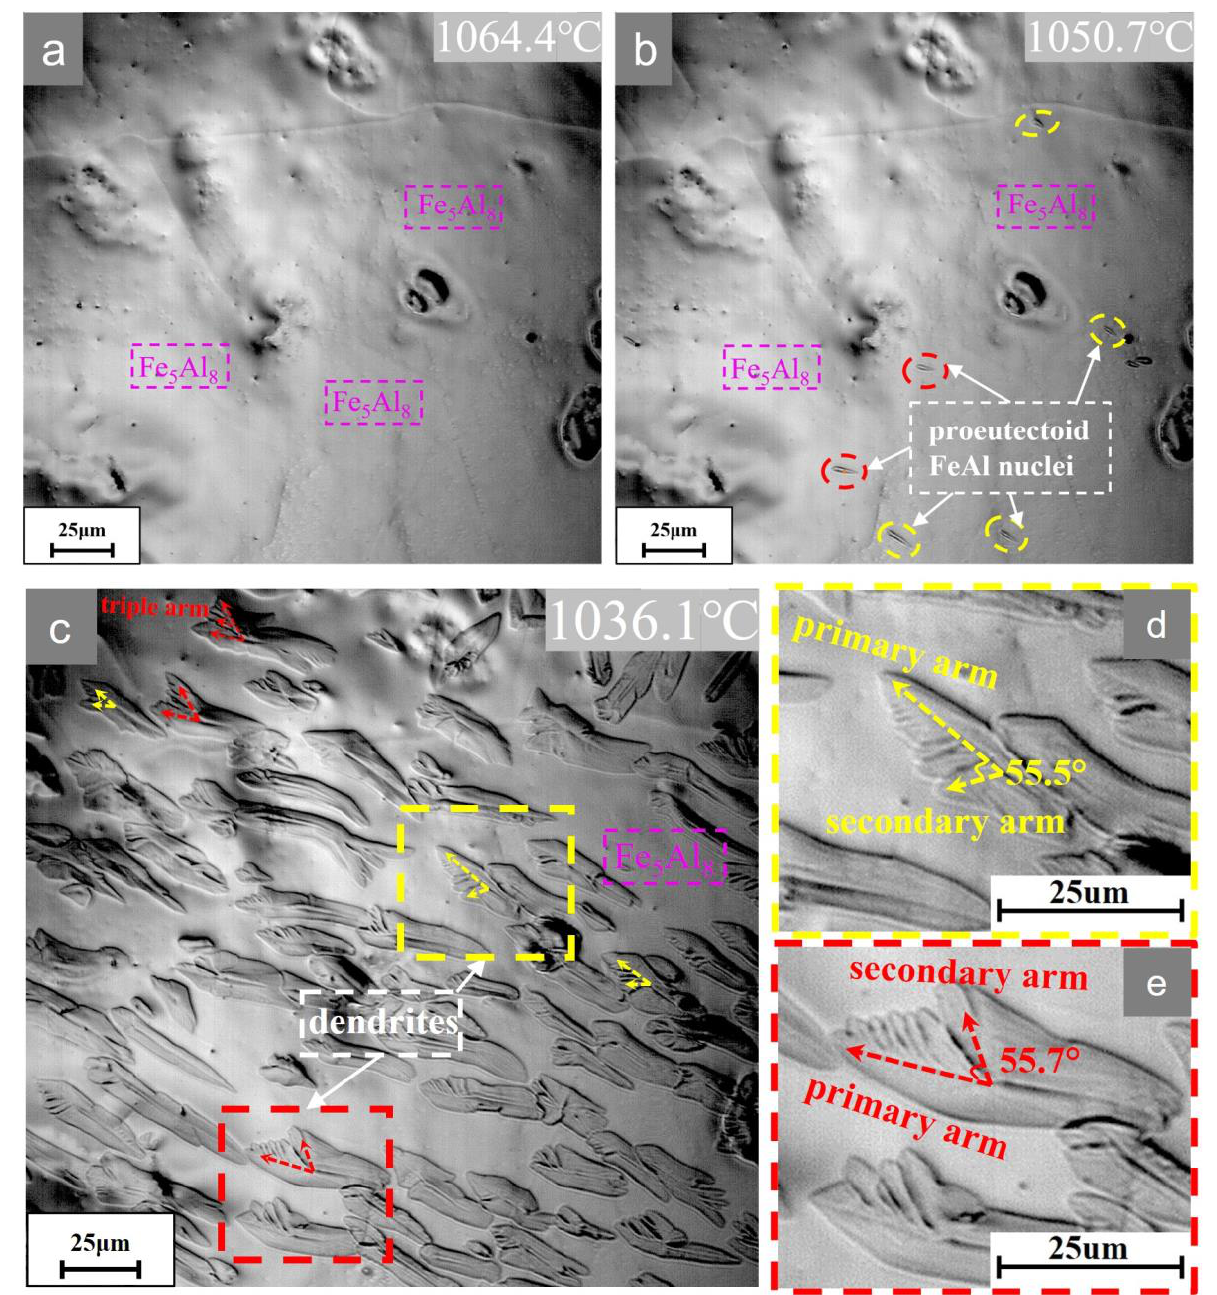
Figure 4. Microstructural evolution of Fe-59.9Al alloy during cooling according to Scheme II.